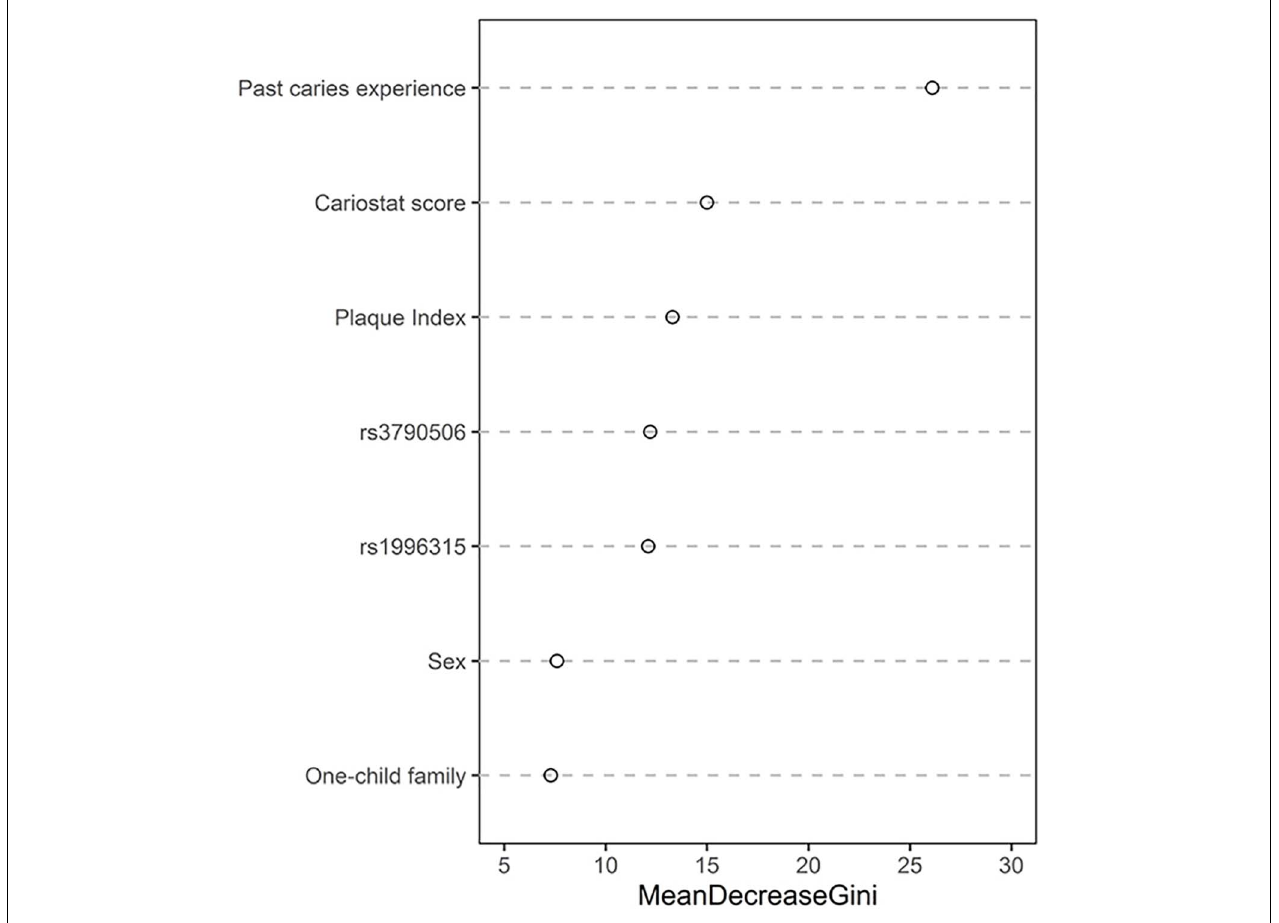
FIGURE 4 | The Gini coefficient of the random forest.